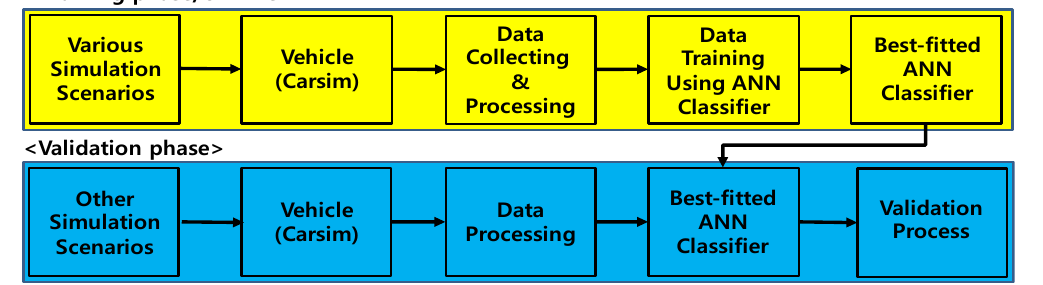
Figure 5. Training and validation phases. The pseudo-codes of both data-processing and best-fitted ANN classifier in road fric- tion estimation are shown in the Algorithm 2 and applied to the individual wheel. # Data averaging Algorithm 2 Road Friction Estimation for Each Wheel